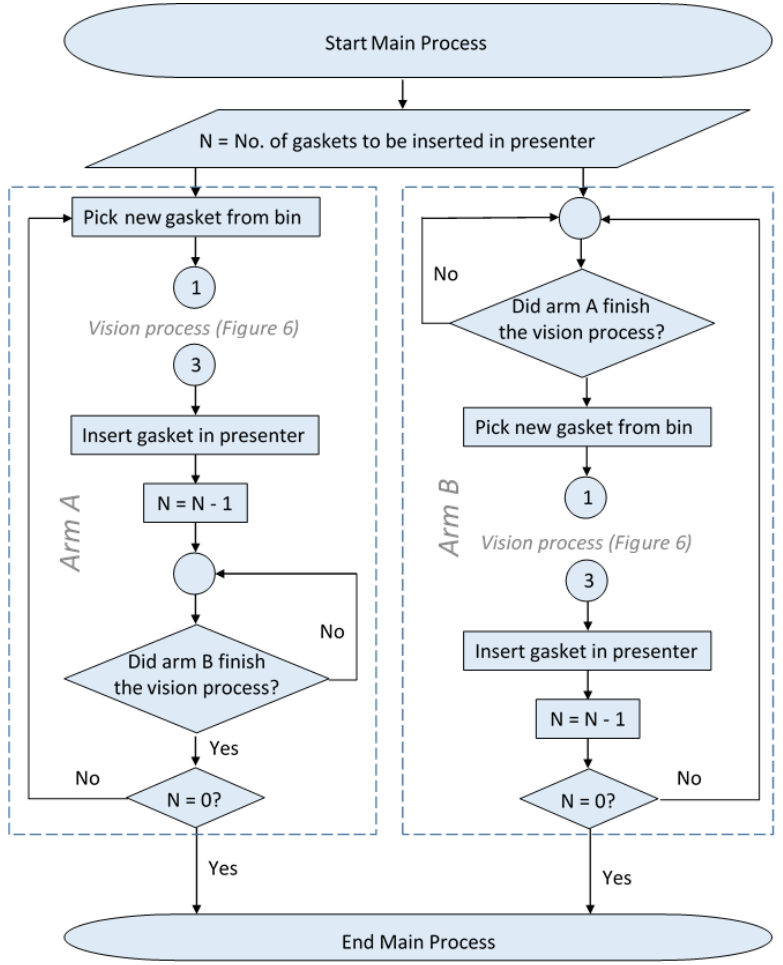
Figure 4. The flowchart of the main process.